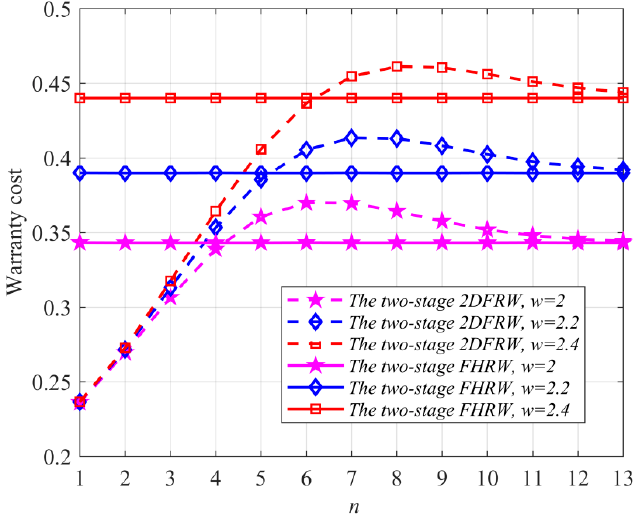
Figure 1. The impact of the coverage range of the former stage warranty on the two-stage 2DFRW.